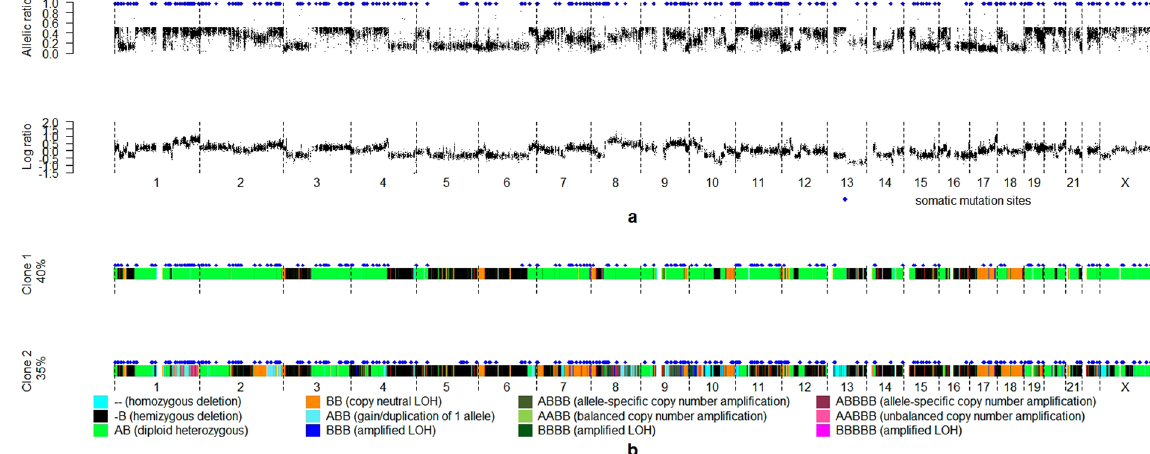
Figure 1. Example THEMIS input observations and the corresponding inferred outputs. ( a ) Inputs to THEMIS, including allelic ratio, log ratio and genomic position information. Somatic mutation sites are indicated by blue diamonds. ( b ) Outputs of THEMIS show that there are two tumor clones in the tumor biopsy, one parent tumor clone with 40% cell prevalence and one child tumor clone with 35% cell prevalence. The CNAs of the two tumor clones are visualized with color bars across the genome, and the genomic positions hosting an SNV are indicated by blue